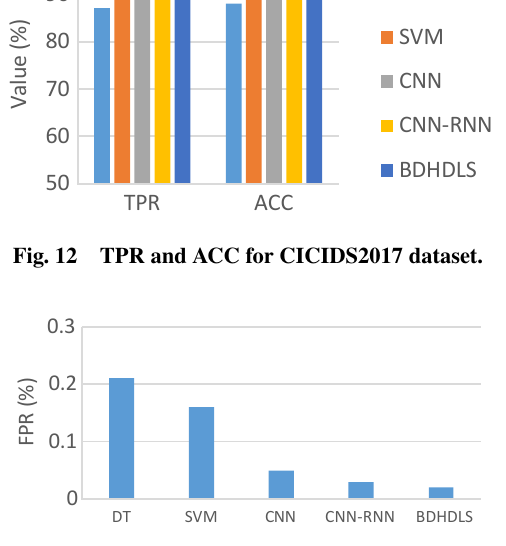
Fig. 13 FPR for CICIDS2017 dataset.